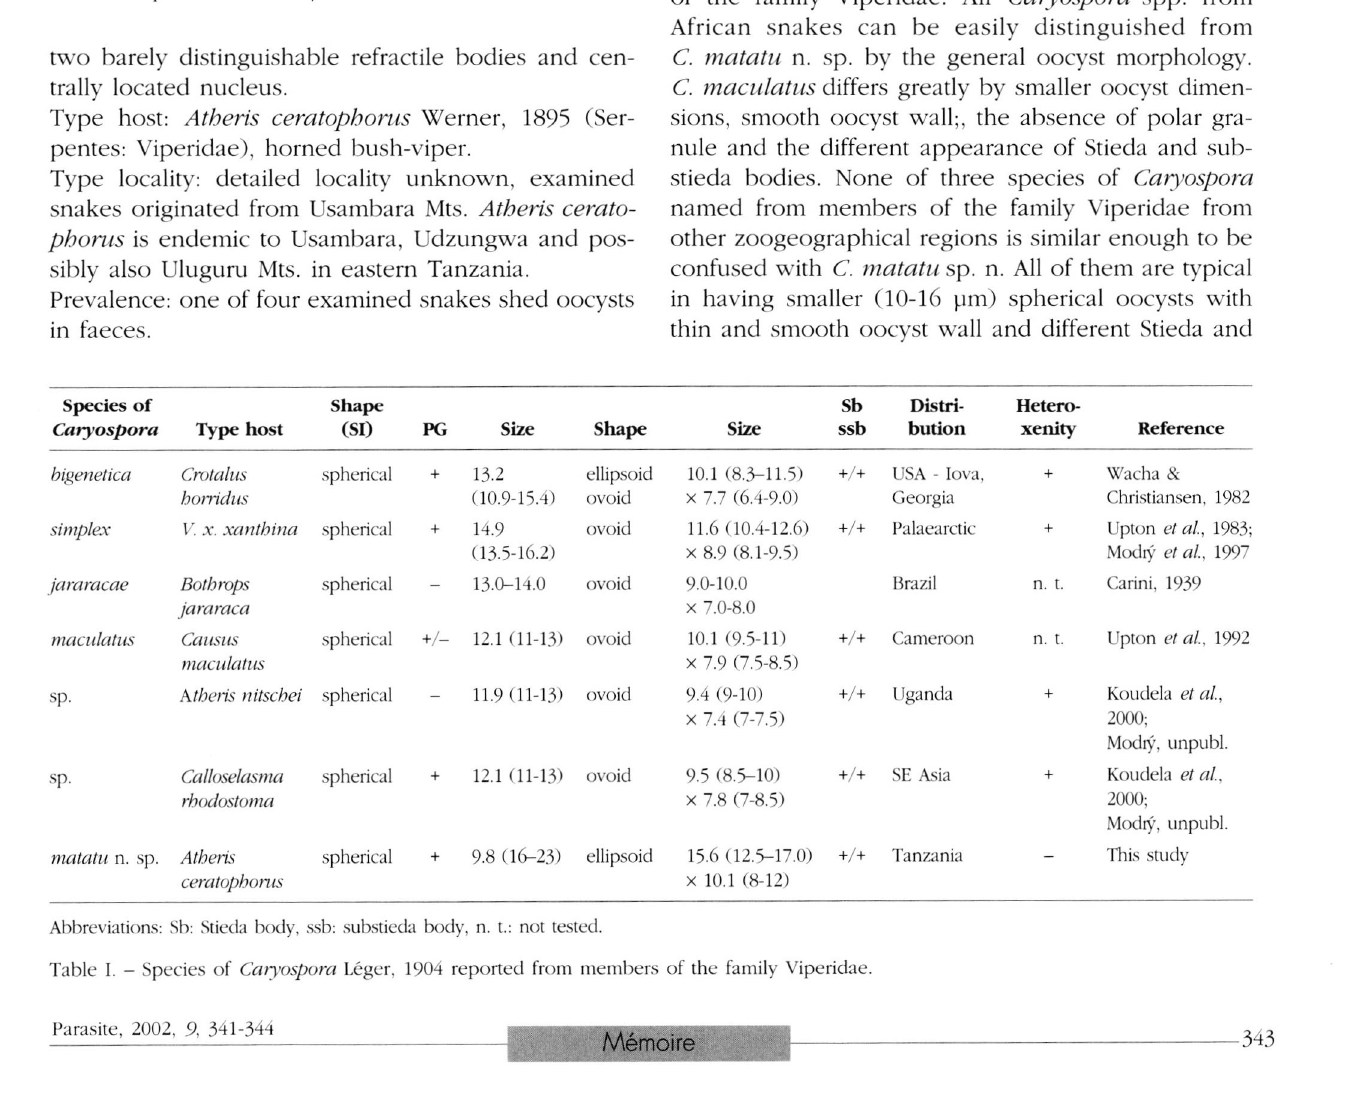
Fig. 3- - Composite line drawing of sporulated oocyst of Caryospora matatu n. sp. Scale bar = 10 urn.